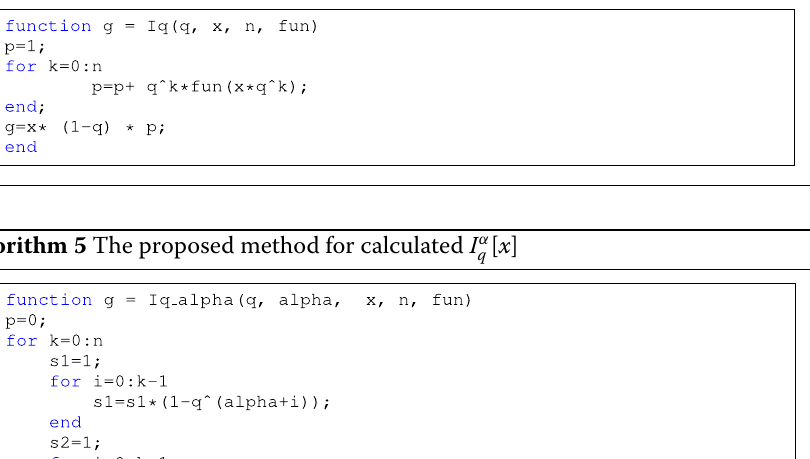
Algorithm 4 The proposed method for calculated